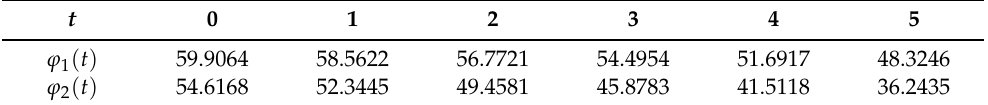
Table 5. Cooperative solution for the subgames G ( n = 2, s ( t ) , T − t , λ ) . t 0 1 2